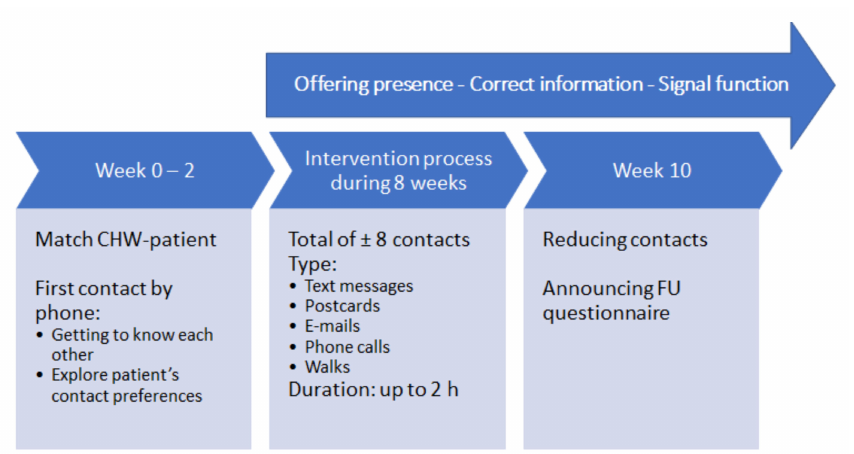
Figure 1. Summary of the intervention process.